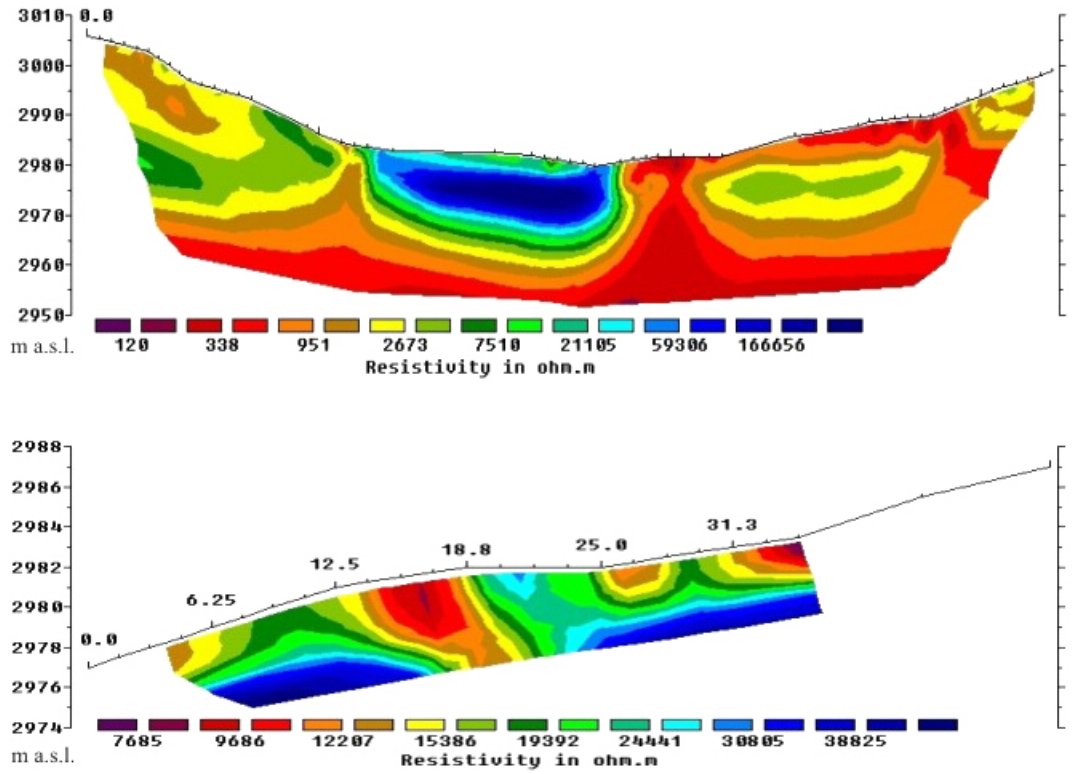
Figure 6. Geophysical prospection over the whole of transect A, transversal to the rock glacier in its middle stretch and adjacent margins (N–S; top) and transect B, longitudinal to the rock glacier (W–E; bottom) (source: